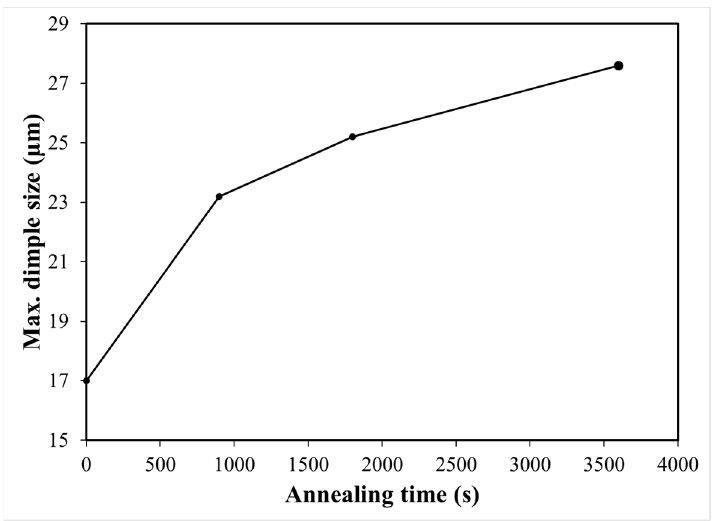
Figure 13. Effect of annealing time on the maximum dimple size on the tensile fracture surface.